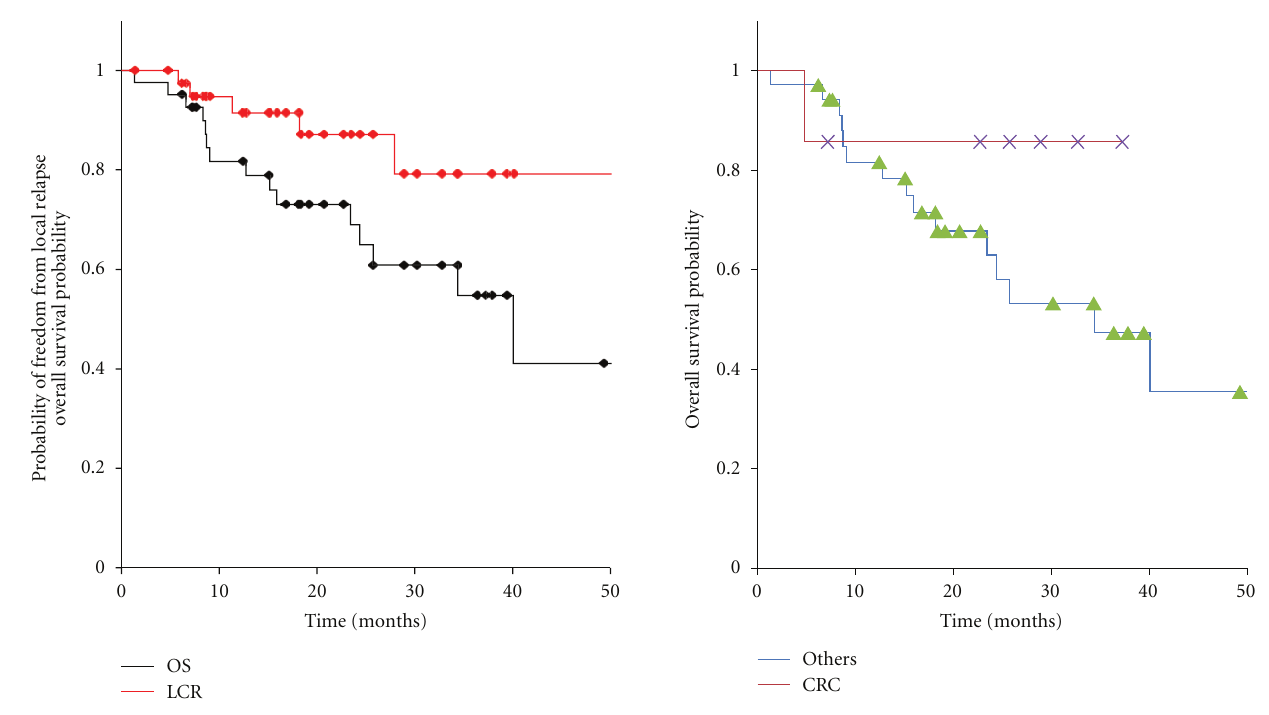
Figure 1: Overall survival and local control of 42 patients with oligo-recurrence cancer in the lung.